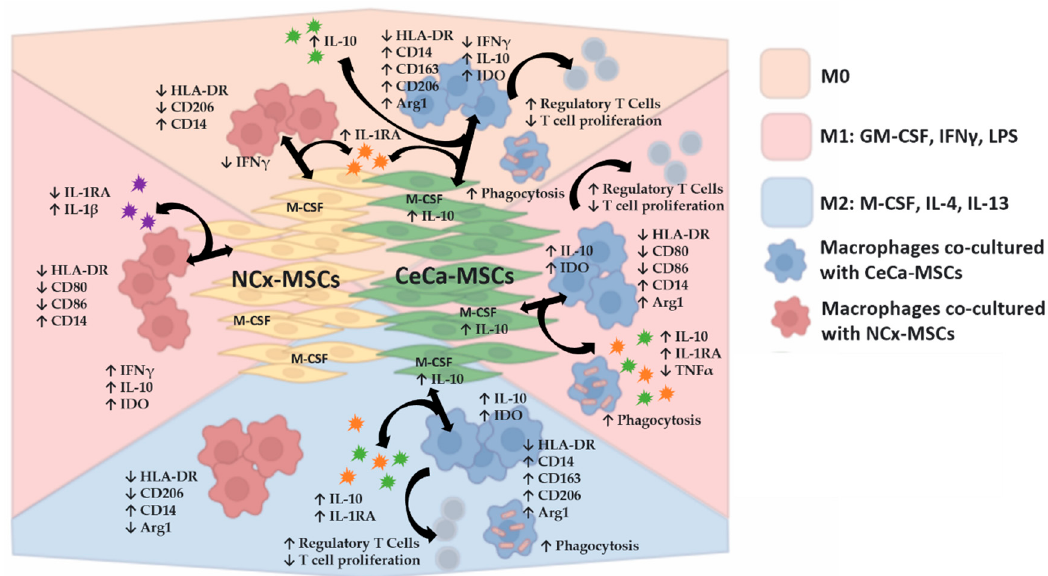
Figure 8. CeCa-MSCs promote the in vitro M2 polarization of macrophages in the presence of molecules that favor an anti-inflammatory or pro-inflammatory phenotype. Schematic diagram of the in vitro mechanism of macrophage polarization toward the M2 phonotype mediated by CeCa-derived MSCs compared with the mechanism of macrophage polarization mediated by NCx-derived MSCs, in terms of the modification of surface markers, intracellular cytokines, phagocytosis in macrophages and also regulatory T cells generation, and decrease in T cell proliferation by these cells. In addition, the diagram shows the expression of intracellular cytokines in MSCs that could participate in such polarization as well as the secretion of cytokines in coculture, in the presence or absence of inducing media that favor M1 or M2 polarization in macrophages. Arrow ↑ , increase; arrow ↓ , decrease.